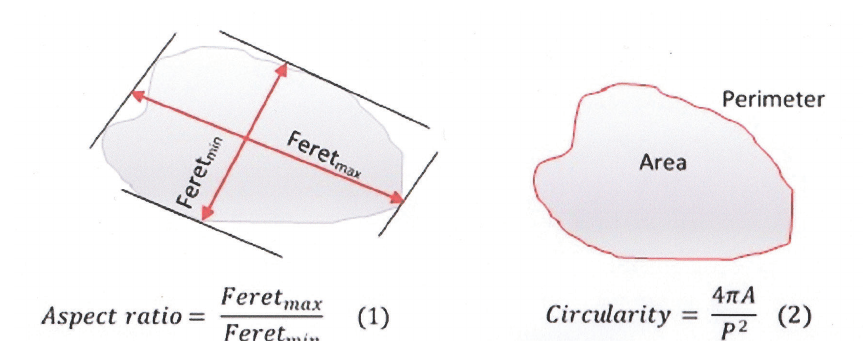
FIGURE 2 - Geometric parameters calculated in analyses of images of multiparticulate forms. Equations (1 and 2) are the most commonly employed - A = area and P = perimeter (Almeida-Prieto; Blanco-Mendez; Otero-Espinar, 2007). data obtained by different laboratories (Almeida-Prieto, Blanco-Mendez,Otero-Espinar,